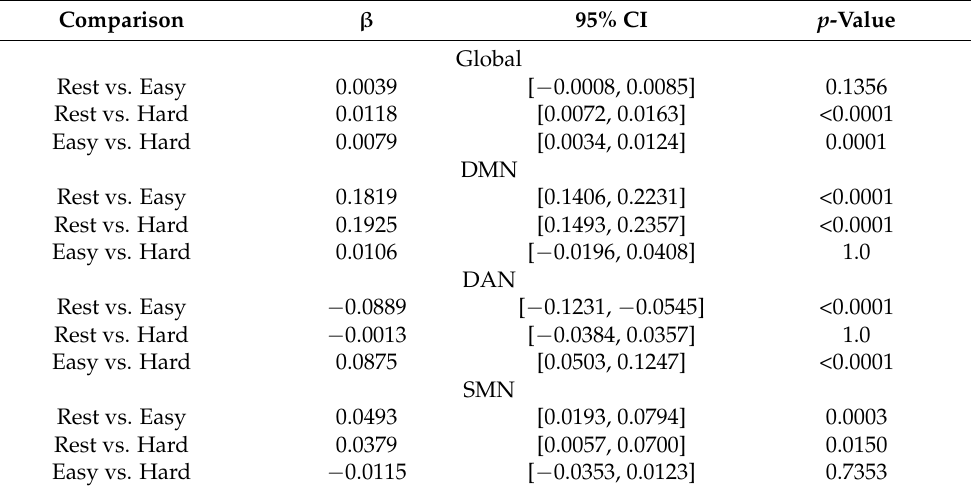
Figure 2. Network consistency is highest during resting-state and declines with the addition of the motor imagery task. Network consistency is significantly lower in the Hard Task when compared to both the Resting state and the Easy Task. * indicates a significant difference from the Resting state. ** indicates a significant difference from the Easy Task. Table 2. Network community structure consistency comparison between task